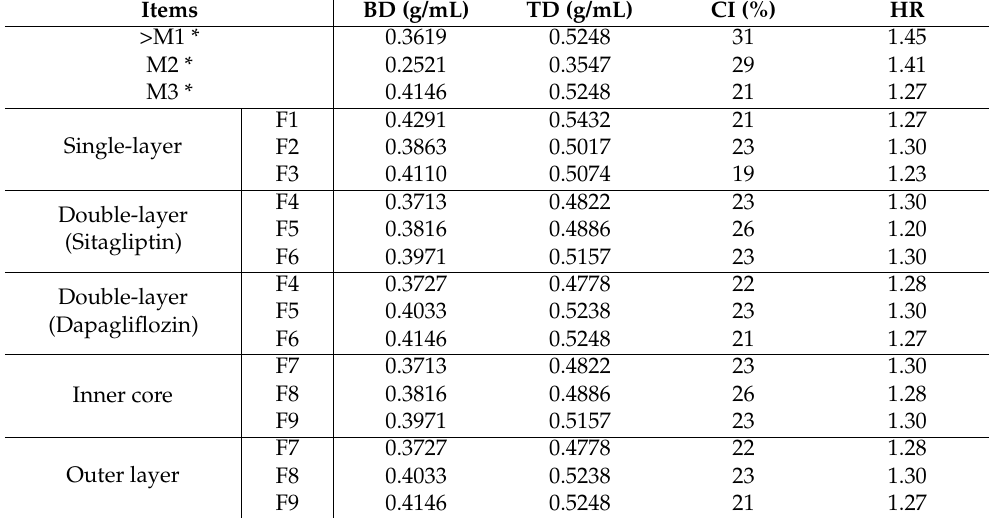
Table 10. Flowability of sitagliptin phosphate monohydrate granules and dapagliflozin propanediol hydrate